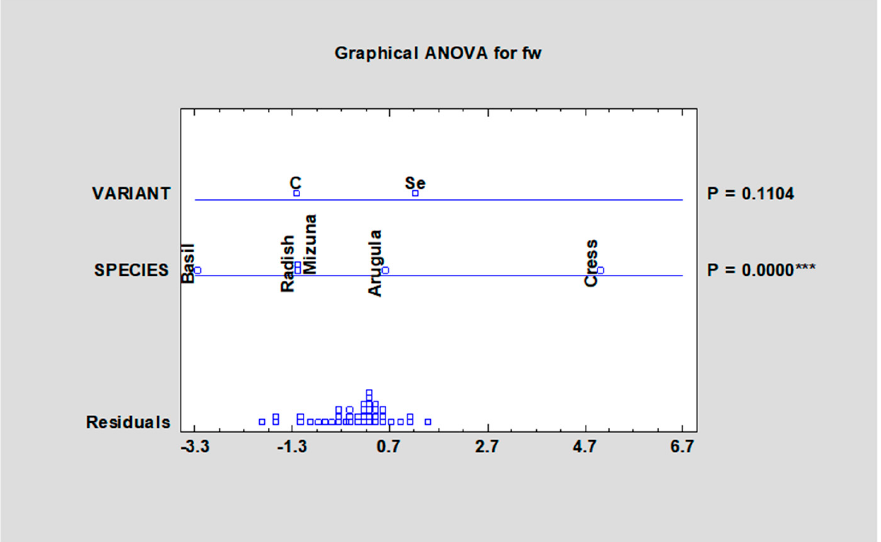
Figure 2. Yield (fw) of microgreens species after fortification with sodium selenate: fw — fresh weight, control; SeAp — selenium application (2 mg Se/L)., *** statistically significant differences at weight, control; SeAp—selenium application (2 mg Se/L), *** statistically significant differences at p ≤ 0.001 (***) by LSD in ANOVA (Statgraphic XVII) p ≤ 0.001 (***) by LSD in ANOVA (Statgraphic